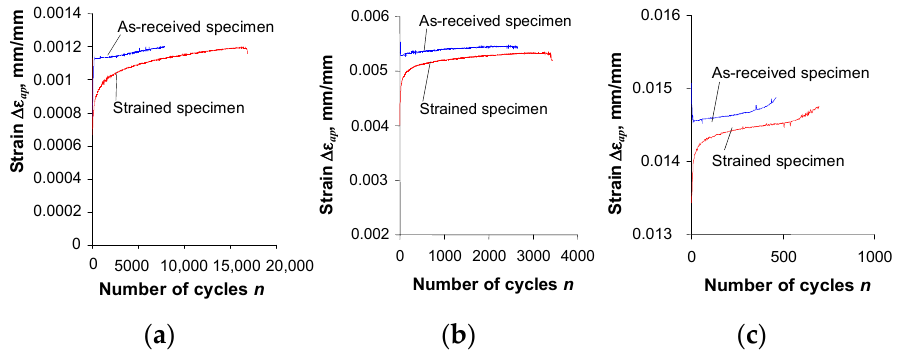
Figure 7. Influence of pre-strain on stress amplitude 𝜎 𝑎 : ( a ) 𝜀 𝑎𝑐 = 0.25%; ( b ) 𝜀 𝑎𝑐 = 0.5%; ( c ) 𝜀 𝑎𝑐 = 1.0%.